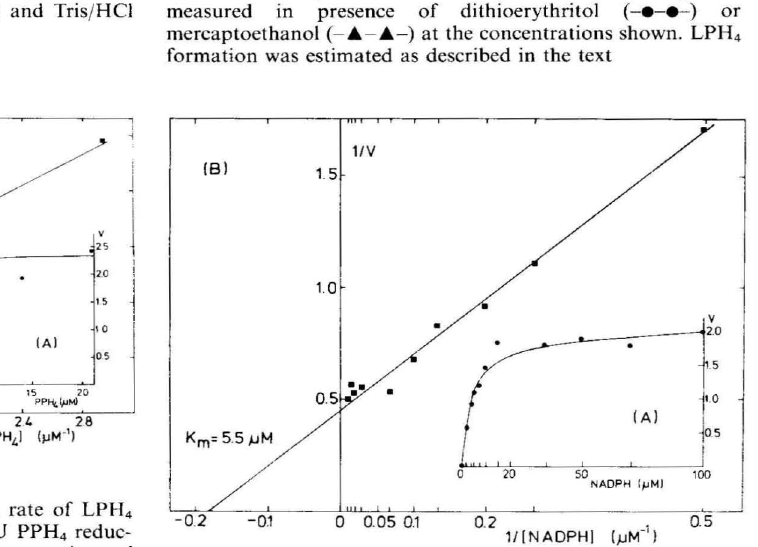
Figure 6. Effect of PPH 4 concentration on the rate of LPH 4 formation. The reaction mixture contained 5 IlU PPH tase, the indicated amount of PPH 4 (after conversion of NH 2 TP), 10 mU PPH 4 synthase (salmon liver), 8 mM MgCh, 0,25 mM dithioerythritol, 2 mM NADPH, 10 mM glucose, 12 U glucose oxidase, 390 U catalase and 0.1 M potassium phosphate huffer, pH 7.0, and was first flushed with N2 as described in the legend to Fig. 3. The assay voiume was 100 ilL, the temperature 37 °C and the reaction was terminated after 5 min. (A) linear plot of total LPH 4 formation (IlM), (y-scale x 10): (B) double-reciprocai plot of the same data